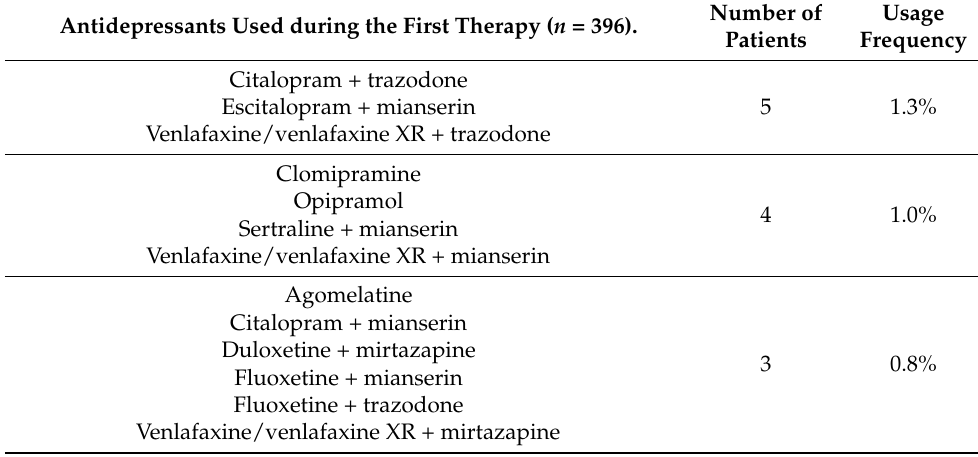
Table 5. Cont. Antidepressants Used during the First Therapy ( n = 396).